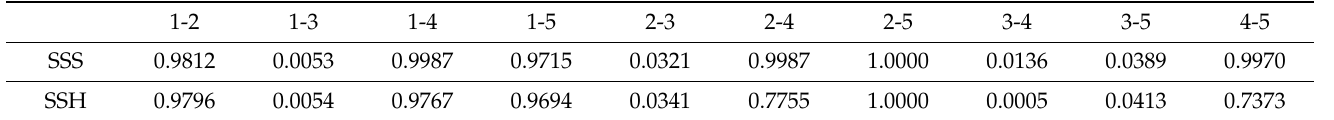
Table 4. p -Values by MCT. (“a-b represents the comparison of the “a” experiment with the “b” experiment, 1: EvensenT, 2: EOFT, 3: WNP1y, 4: EvensenT1y, 5: EOFT1y; the bold font represents the values greater than